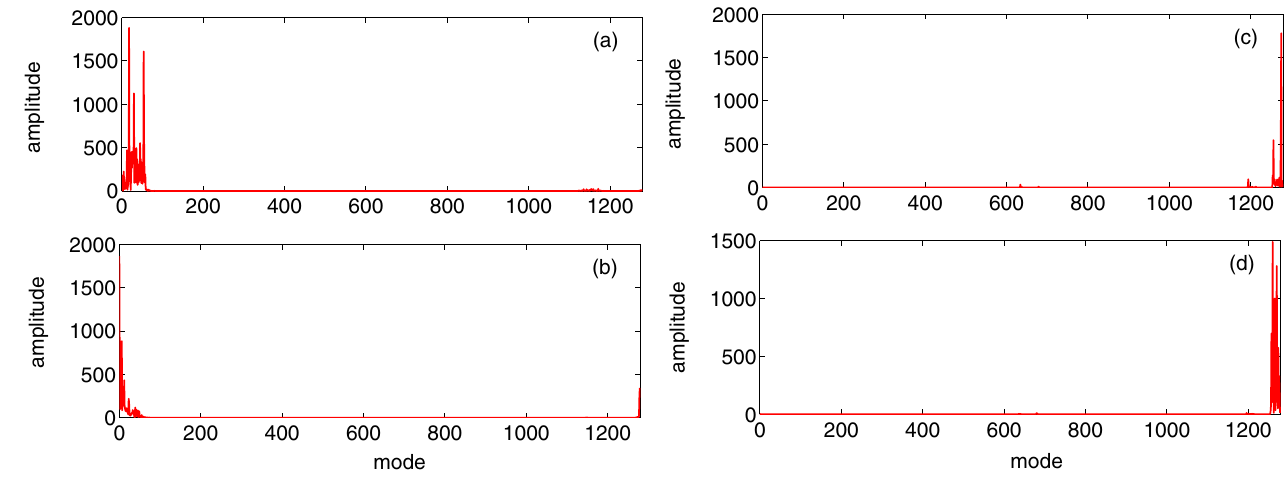
FIG. 19. (Color) Mode spectra of the coupled-bunch instability caused by an electron cloud in a weak solenoid field. Plots (a) and (b) depict the horizontal and vertical spectra for B